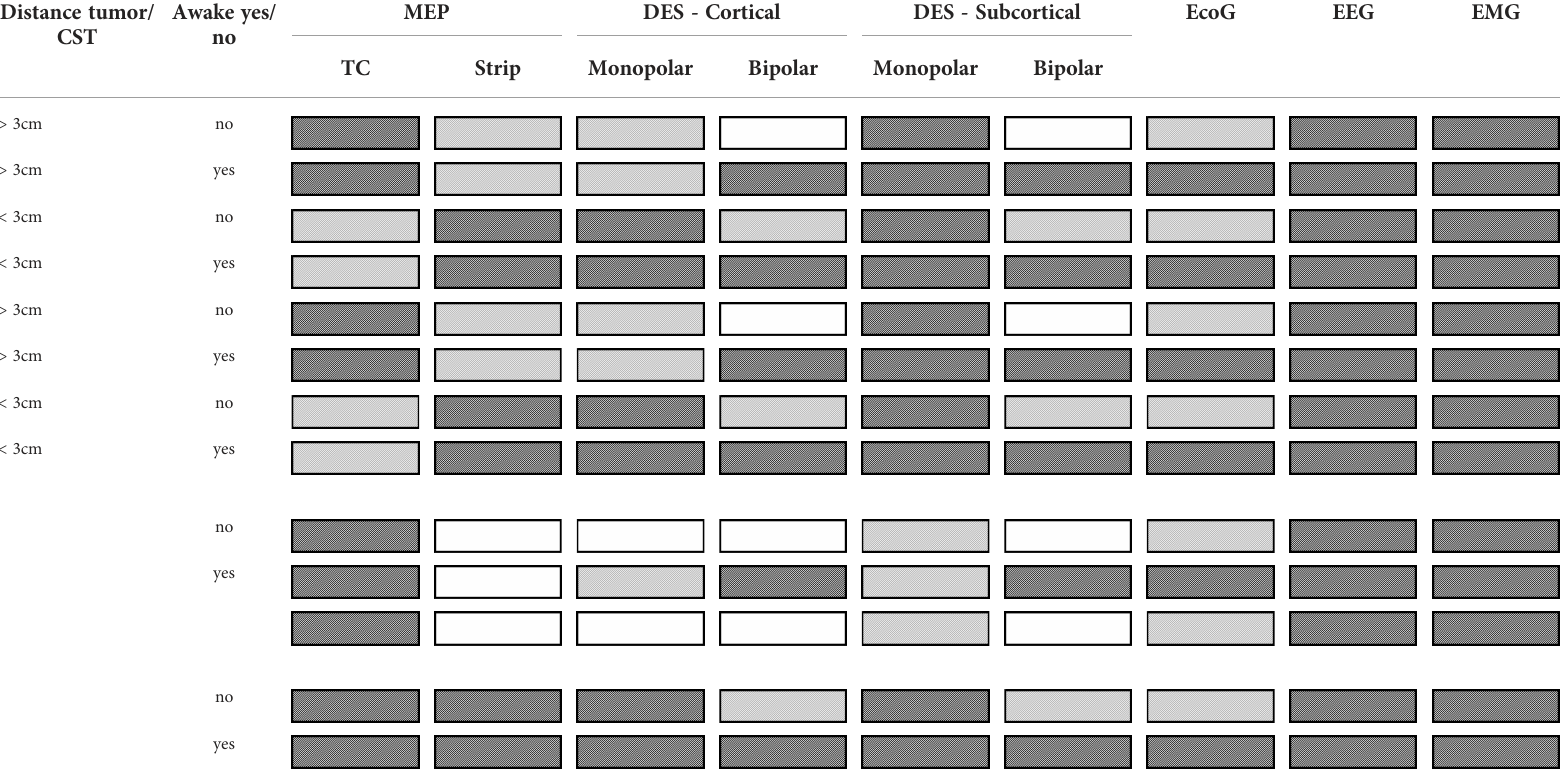
TABLE 1 The scheme used for IONM choice according to the surgical procedure to be performed.